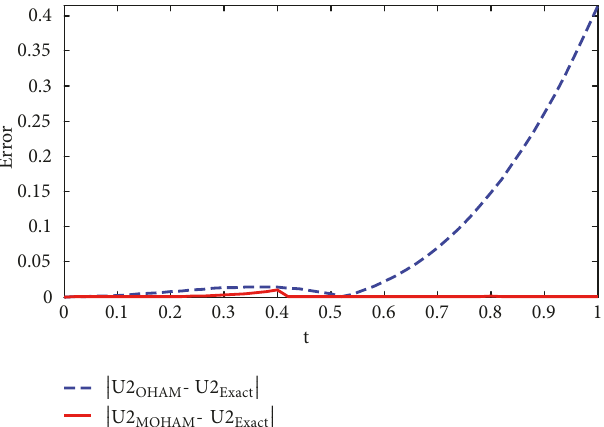
Figure 8: Absolute errors OHAM and MOHAM for u2 in Example